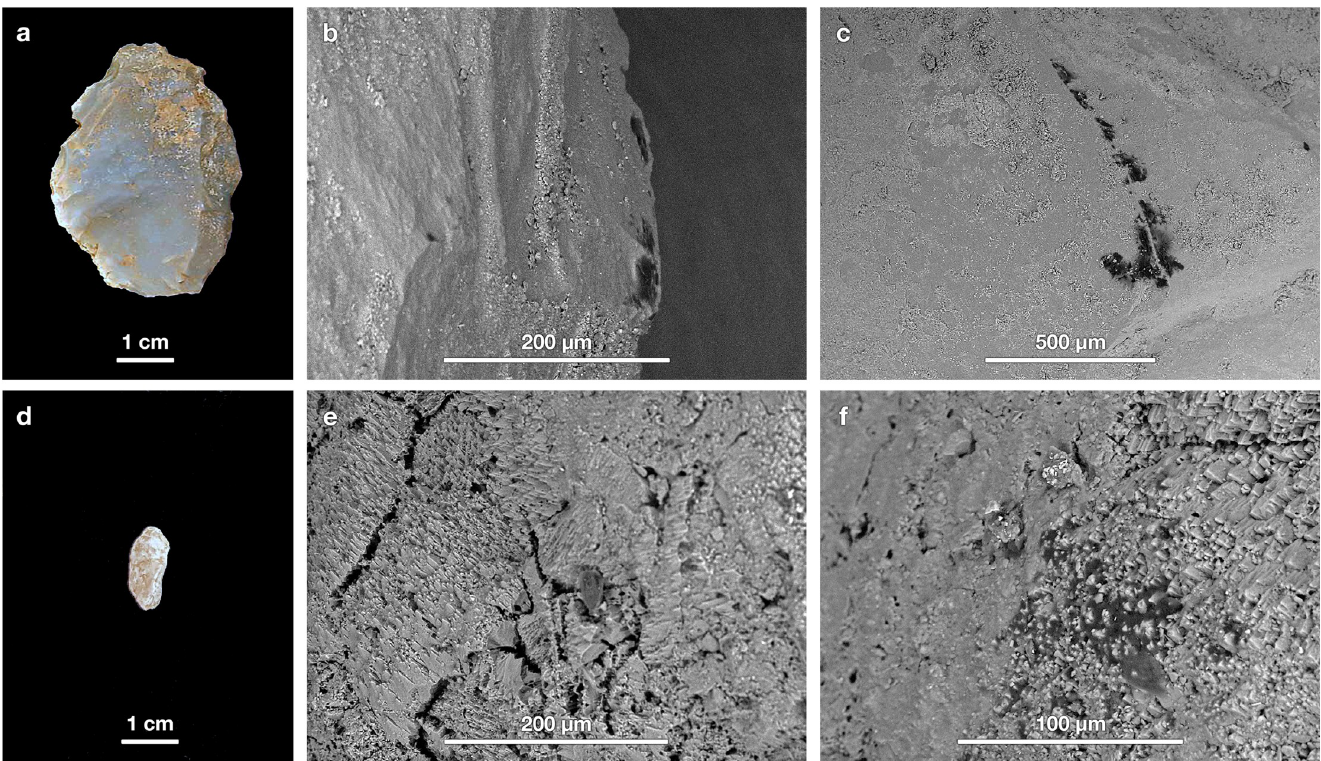
Fig 13. Example artifact and geofact. (a) A retouched atypical Levallois flake made of brown-grey chert and (d) an unmodified stone from sediment packet M89-9 both exhibit the presence of microscopic organic residues in SEM images (b, c, e, f).